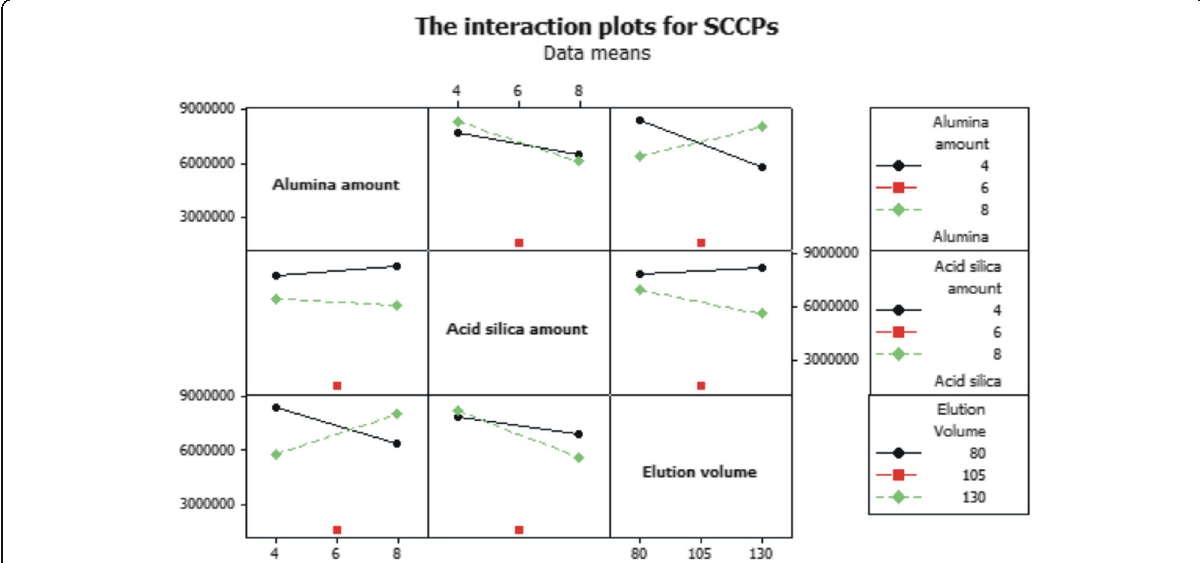
Fig. 3 Interaction plots of the three factors (alumina amount, acid silica amount, and elution volume) for SCCP